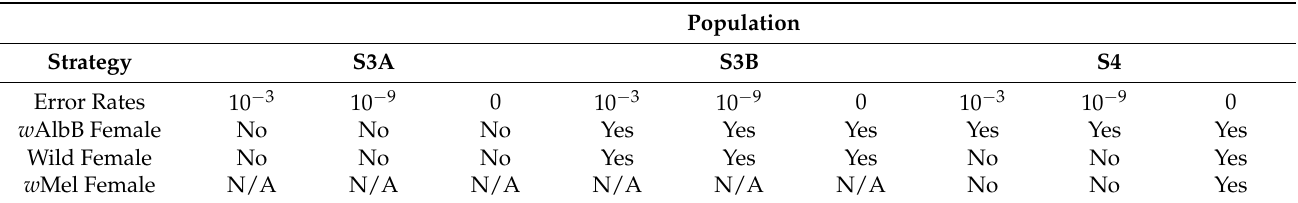
Table 3. Successful elimination of specific mosquito populations at simulation endpoint. “Yes” indicates the successful elimination of the respective mosquito population. “No” indicates that there was no elimination of the respective mosquito population.“N/A” indicates that the population was not released under that scenario.